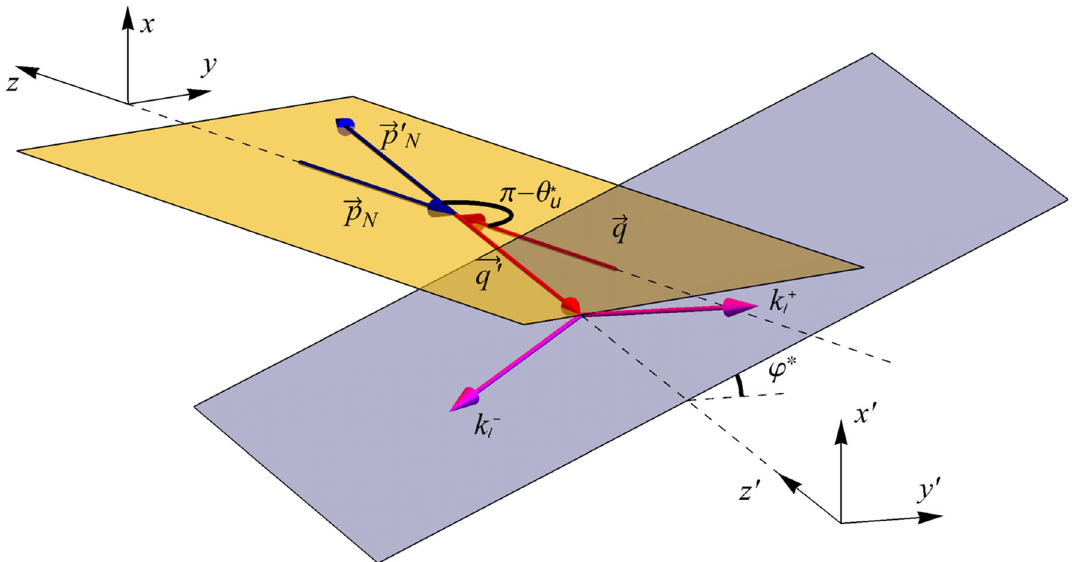
Fig. 4 The Bethe Heitler process for exclusive photoproduction of a lepton pair on a nucleon. The red disk represents the electromagnetic nucleon form factors F 1 , 2 ( t ) ; − t is small in the near-forward kinematics but large in the near-backward kinematics studied here